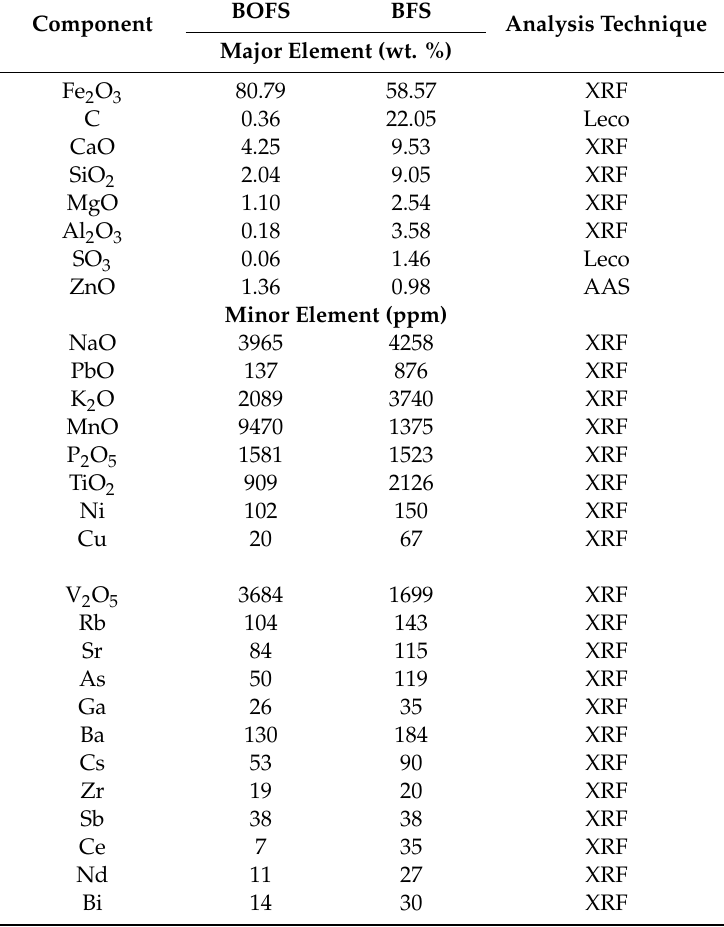
Table 1. Detailed chemical composition of BF and BOF